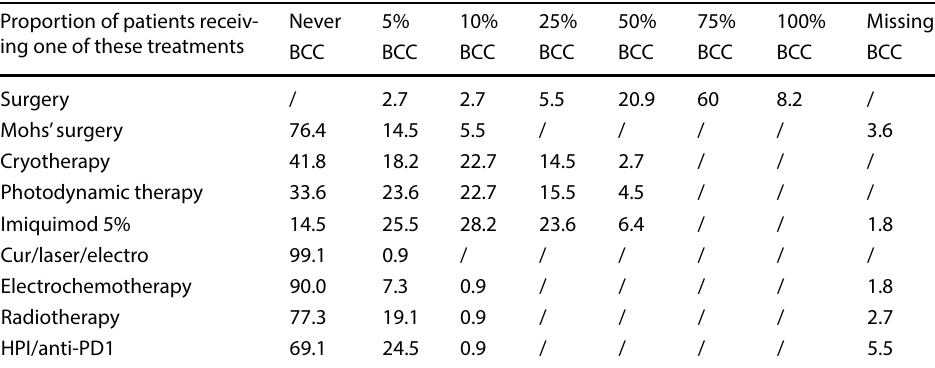
Table 3 % of therapies for BCC according to dermatologists